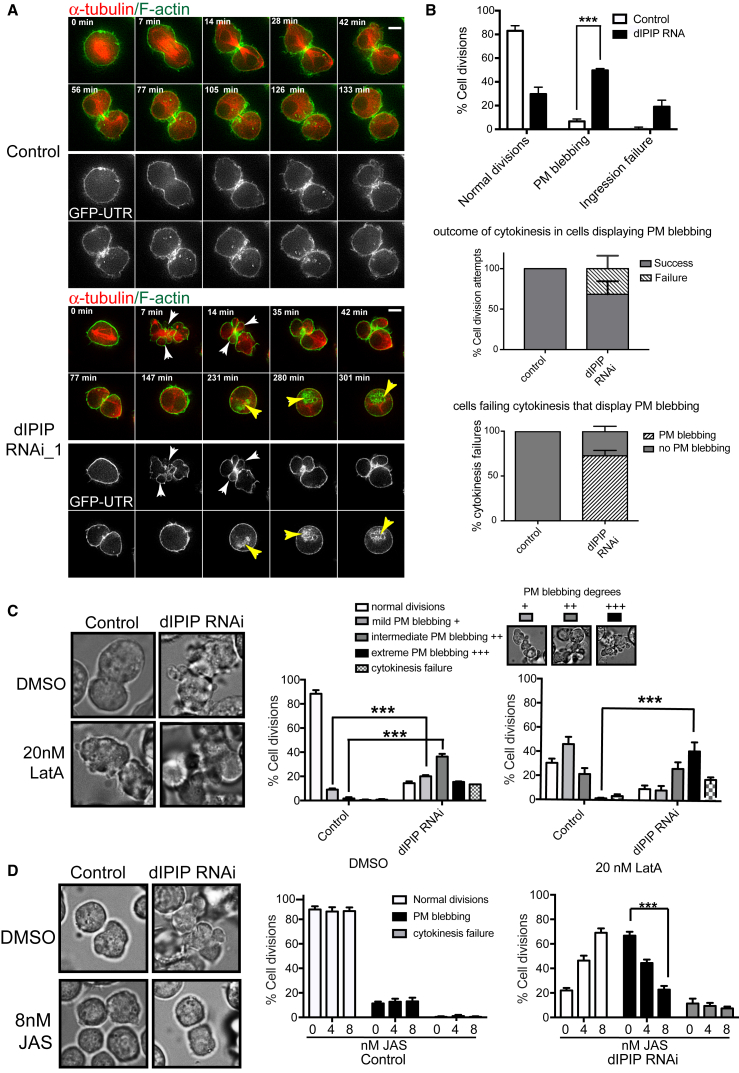
Depletion of dIPIP Causes Cortical Actin Instability during Cytokinesis(A) Live stills showing dynamics of GFP-Utrophin in control or dIPIP-depleted cells during cell division. White arrowheads show cortical blebs and yellow arrowheads mark intracellular vacuoles. Time is in minutes from the last frame of metaphase. Scale bar, 5 μm.(B) Top: quantification of cell division phenotypes. Middle, quantification of cell division outcome in blebbing cells. Bottom: quantitation of cells failing cytokinesis that had undergone blebbing. Bars represent mean from 3 experiments with 80–100 cells per experiment. Error bars show SEM. ∗∗∗p < 0.0005, chi-square analysis.(C and D) Left: bright-field stills of control or dIPIP-depleted cells treated with DMSO, 20 nM latrunculin A (LatA; C), or 8 nM jasplakinolide (JAS; D). Right: quantification of phenotypes upon LatA (C) or JAS (D) treatment. Bars represent the mean of 3 experiments with >100 cells analyzed per condition per experiment. Error bars represent SEM. ∗∗∗p < 0.0005, chi-square analysis.See also Video S3.